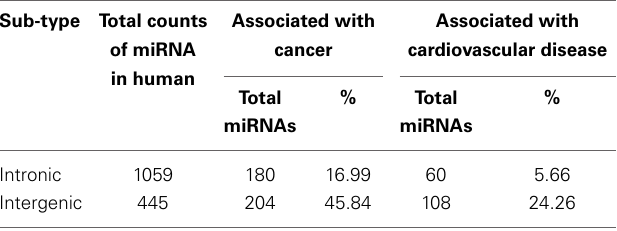
Table 4 | Percentage of prevalence of miRNA sub-types associated with